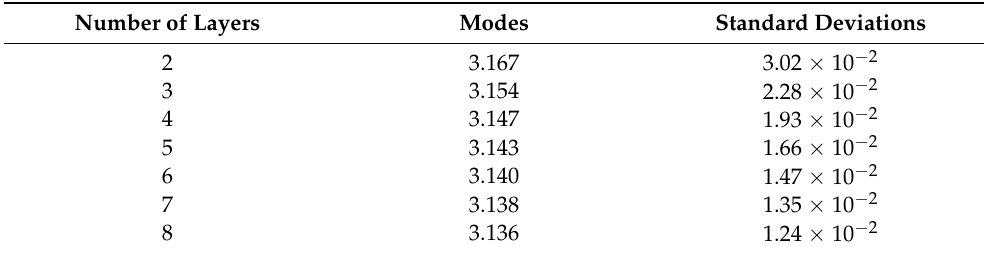
Table 7. Modes and standard deviations for the saturation density of 0.55 and the given number of layers.